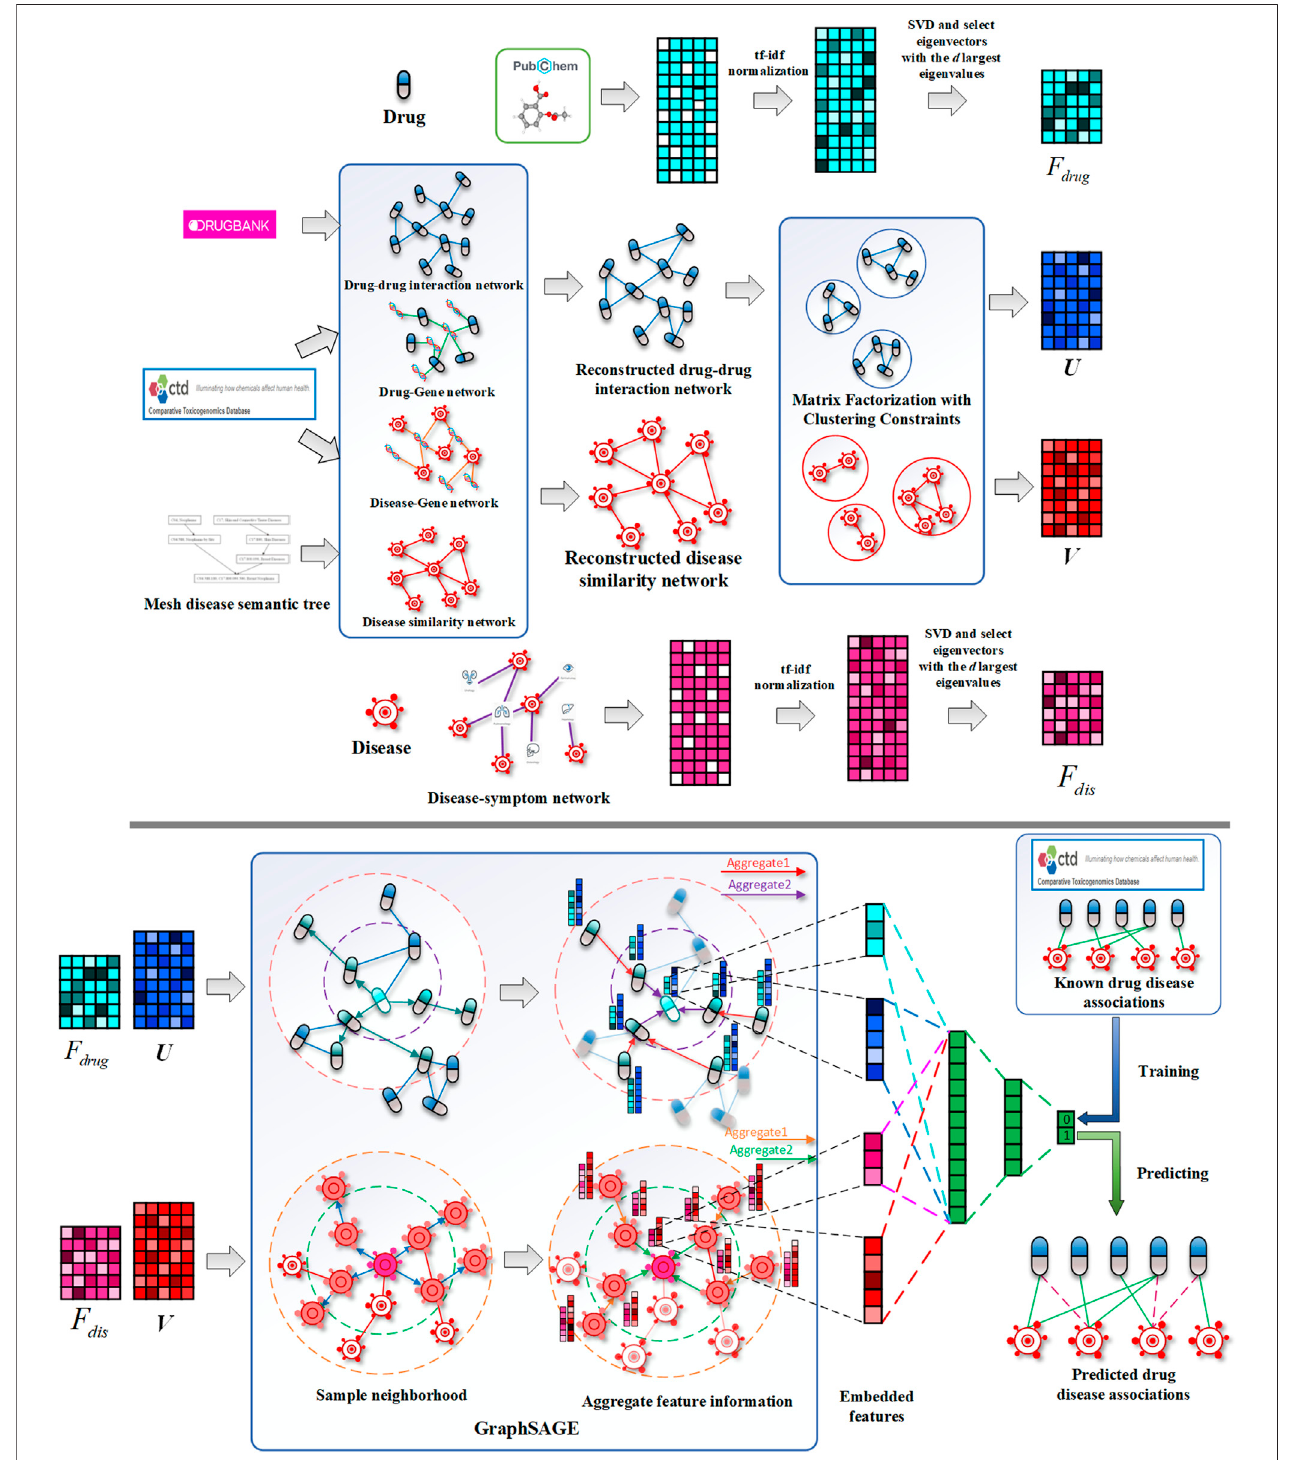
FIGURE 1| Schematic diagrams ofdata processingand DRGCC model. 1) Reconstruct the drug interaction network and establish the disease similarity network, 2)extracttheattributesfeatureofdrugsanddiseases,3)obtainnetworkclusteringfeaturesofdrugsanddiseases,and4)constructtheGraphSAGEpredictionmodelto predict potential drug – disease